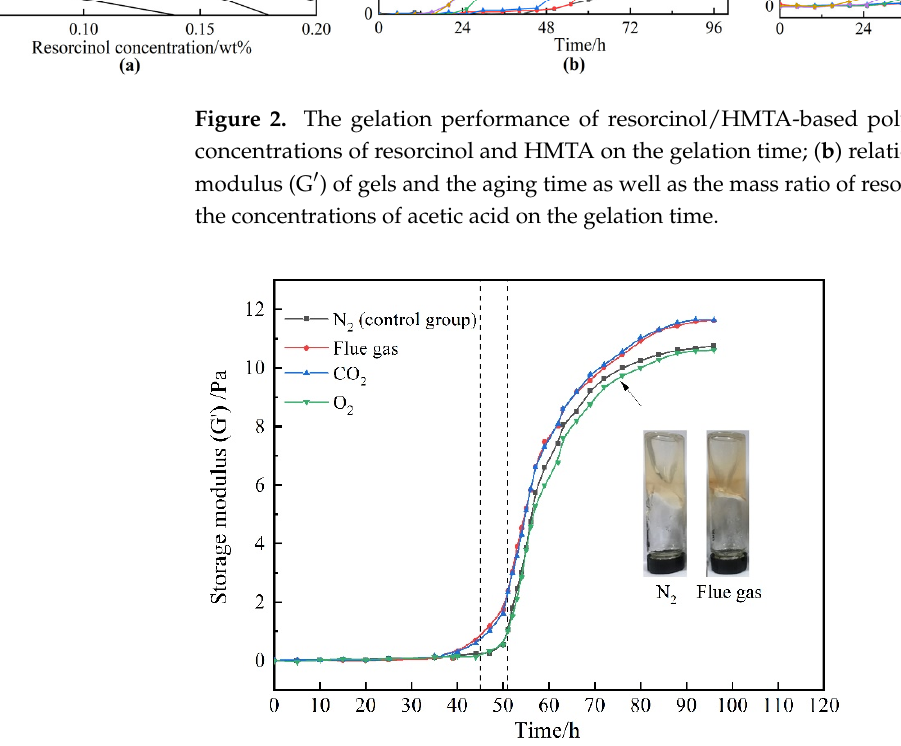
Figure 3. The influence of gas species on gelation